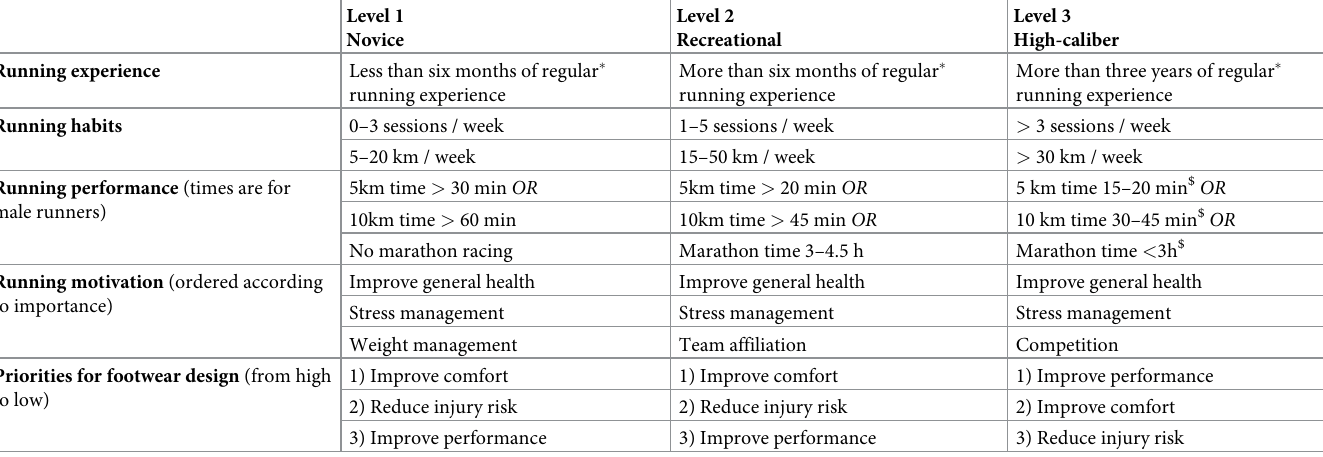
Table 1. Initial definitions of running